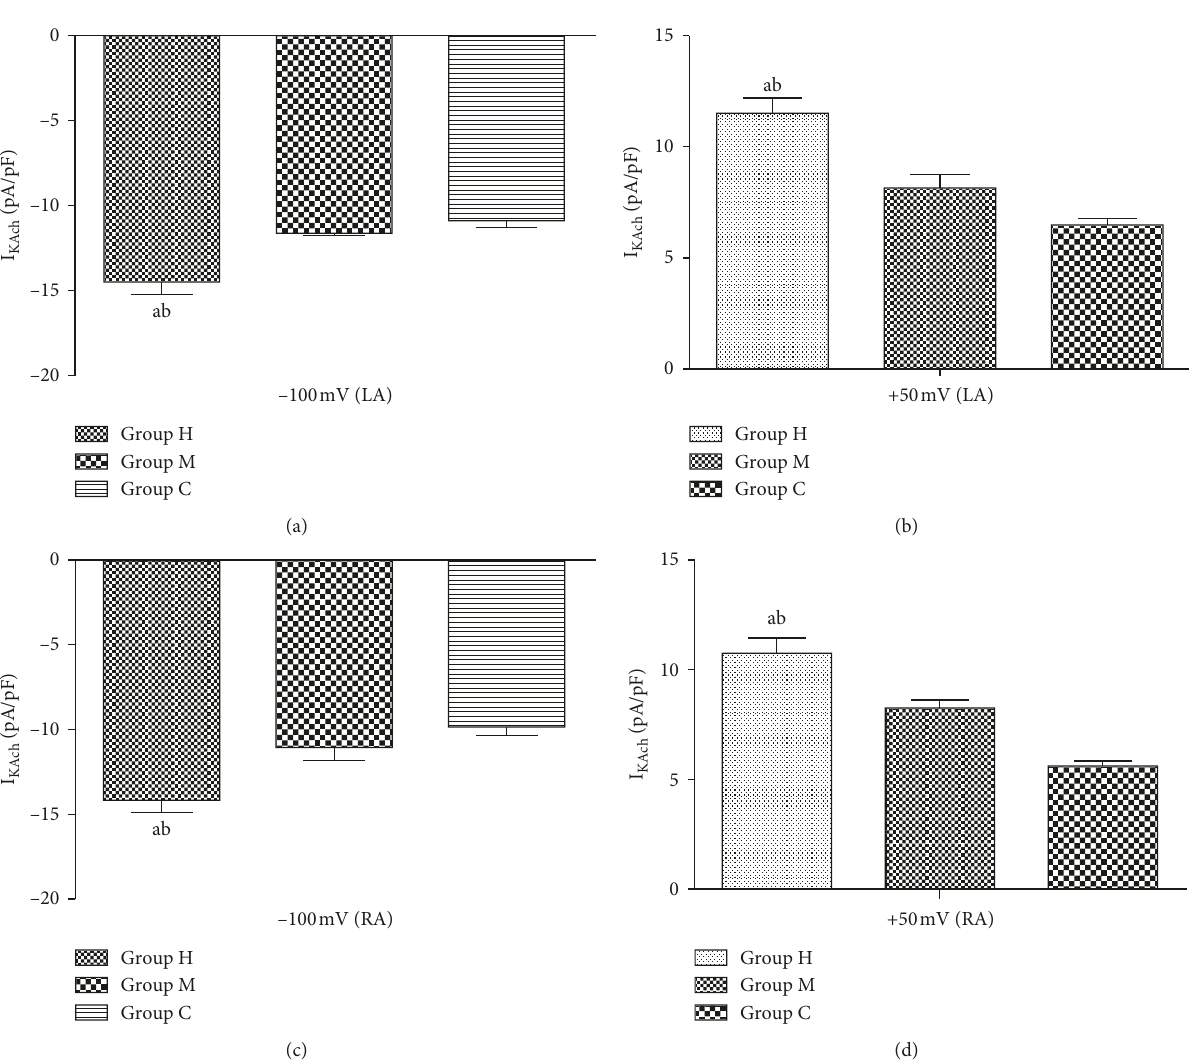
Figure 4: Effects of different-intensity continuous training on atrial tissue IKAch current density in rabbits. (a, c) Clamping voltage:100mV; (b, d): clamping voltage +50mV. Compared with Group C, a P < 0 . 05; compared with Group M, b P < 0 .